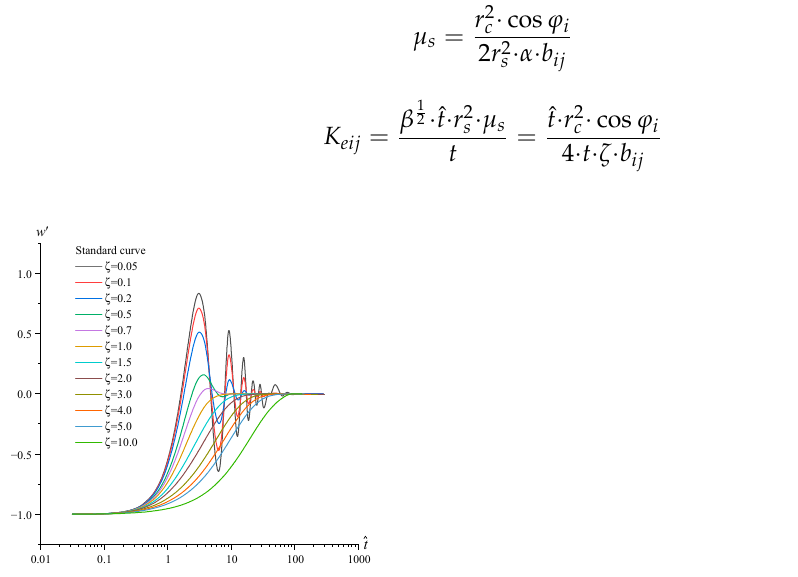
Figure 2. Slug test standard curve of determining different dip angle fracture permeability coefficients.